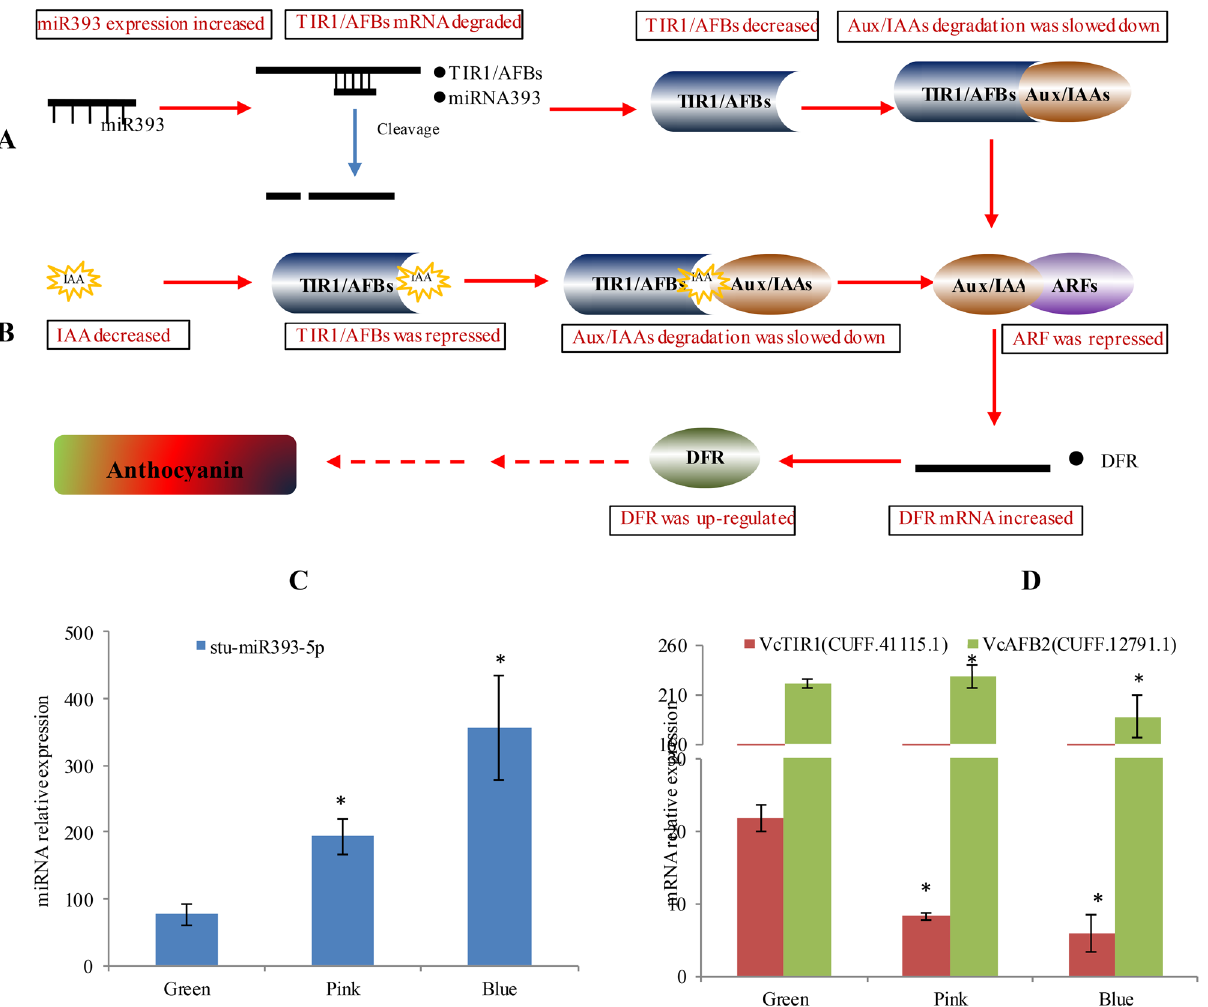
Figure 5. A schematic diagram of changes in auxin signal transmission during blueberry fruit maturation. (A) VcmiR393 was up-regulated, which down-regulated VcTIR1, slowed down degradation of Aux/IAAs and suppressed activity of ARFs (B) As auxin (IAA) gradually decreased during maturation, TIR1/AFBs were repressed accordingly, which also slow down degradation of Aux/IAAs. Thus, IAA and VcmiR393 had dual effects on suppressing ARFs to induce VcDFR expression and accelerated anthocyanin biosynthesis. (C) VcmiR393 was up-regulated (D) VcTIR1/AFBs were posttranscriptionally repressed. Error bars represented standard errors from three biological replicates (ten fruit as one replicate). "*" indicates the differences between green, pink and blue phases are significant (T test; *:P <